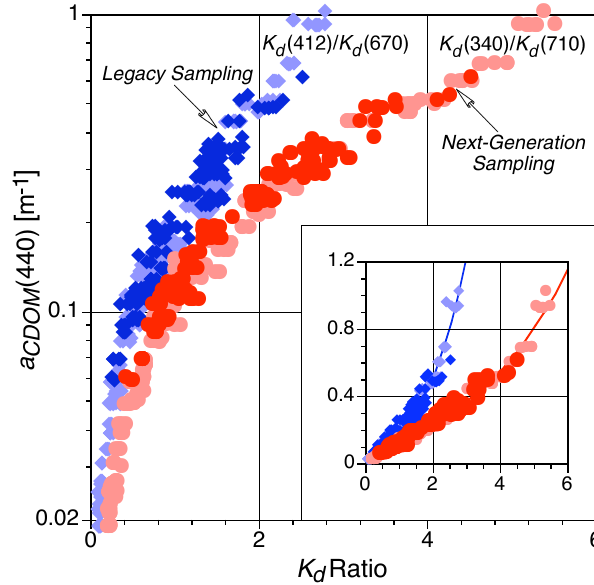
Fig. 8. The relationship between K d ( 320 )/K d ( 780 ) and a CDOM ( 440 ) for the Malina data set and the resulting linear least-squares fit of the data (solid black line), with the fitting parameters shown bottom right. The inset panel (top left) shows the same data with a logarithmic x-axis to improve the clarity of the data with low K d ( 320 )/K d ( 780 ) values. The open circles (one atop the other) are two data points that were ignored in the fit because they appear as unexplained outliers.